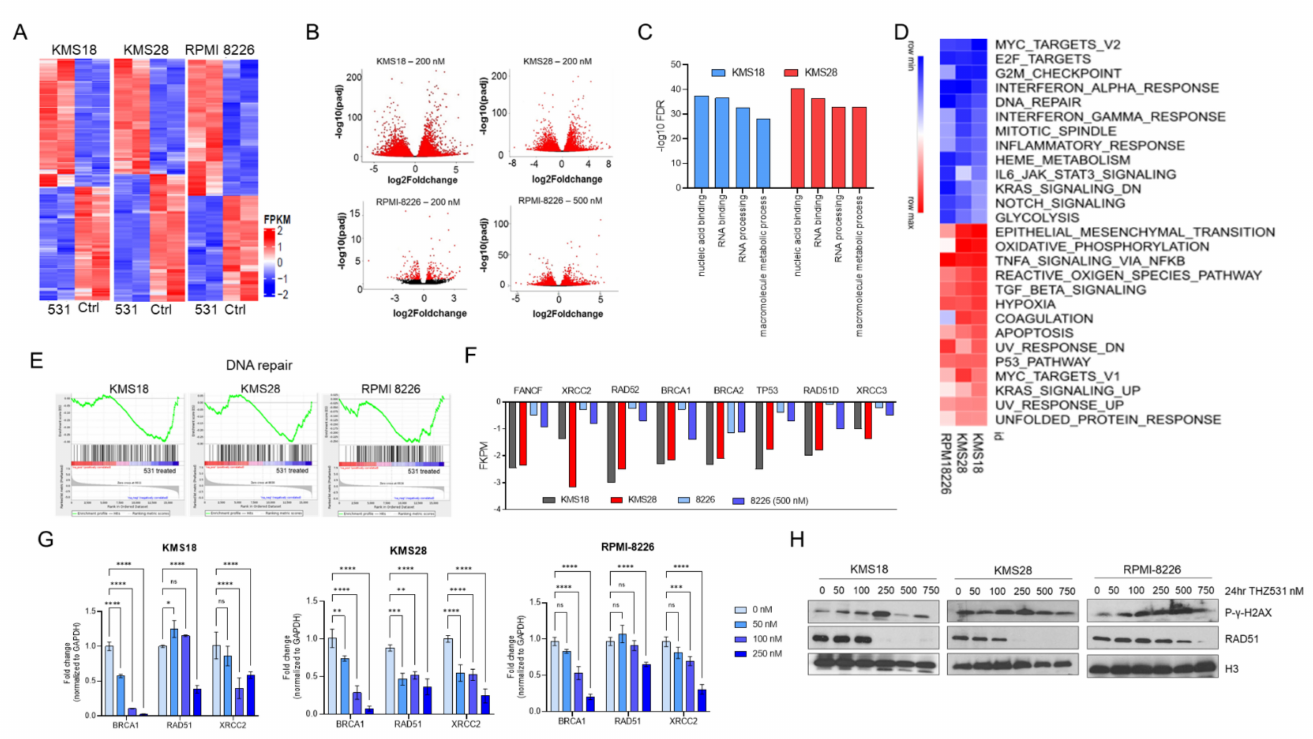
Figure 2. THZ531 treatment downregulates genes involved in DNA repair pathways and induces DNA damage in MM cells ( A ) KMS18, KMS28, and RPMI-8226 were treated with 200 nM THZ531 for 6 h in duplicates. Heatmap displays the log2 fold change in gene expression for THZ531 versus DMSO treatment. ( B ) Volcano plots depicts the effect of 200 nM THZ531 on gene expression. In addition, 500 nM THZ531 on gene expression changes of RPMI-8226 cells is also depicted. ( C ) Gene ontology analysis of genes dysregulated with 200 nM THZ531 treatment of KMS18 and KMS28 cells. ( D ) Heat map of GSEA pathways enriched in MM cells post 6 h of THZ531 treatment. ( E ) GSEA plots for DNA repair pathway gene sets among the downregulated genes 6 h after 200 nM THZ531 treatment. ( F ) FPKM values of genes involved in DNA repair pathways that were downregulated following THZ531 treatment. ( G ) Quantitative real time PCR validation of a set of DNA repair pathway genes treated with increasing doses of THZ 531 (0, 50, 100, 250 nM). Data presented as the mean ± SD of the mean. Statistical analysis was carried out using GraphPad Prism software (GraphPad, La Jolla, CA). Statistical significance was determined ANOVA followed by a Tukey’s posthoc test. ns—not significant, ns- not significant, * p < 0.05 ** p < 0.001, *** p < 0.0002, **** p < 0.0001. ( H ) Immunoblotting for phosphor-gamma H2AX and RAD51 in KMS18, KMS28, and RPMI-8226 treated with increasing doses of THZ531. Histone H3 and GAPDH were used as loading